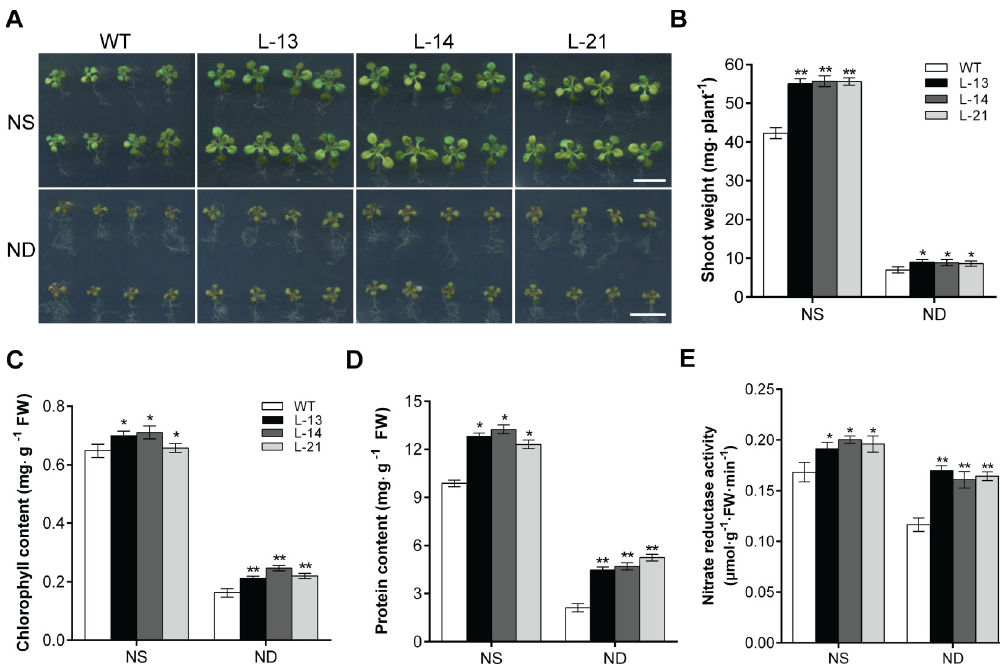
Fig 3. Overexpression of OsATG8b enhances tolerance to N deficiency in transgenic Arabidopsis. (A) 7-day-old seedlings of transgenic lines and WT were transferred to ½ MS medium with sufficient (NS) or deficient (ND) N for 9 days. (B) The shoot weight of WT and transgenic Arabidopsis lines under NS or ND. (C) and (D) The chlorophyll content and soluble protein content in rosette leaves of transgenic lines and WT under NS or ND. (E) The nitrate reductase (NR) activity in rosette leaves of transgenic lines and WT under NS or ND. Bar = 1 cm. Values are means ± SD of three biological replicates (n = 16), � P < 0.05, �� P < 0.01 (t-test).